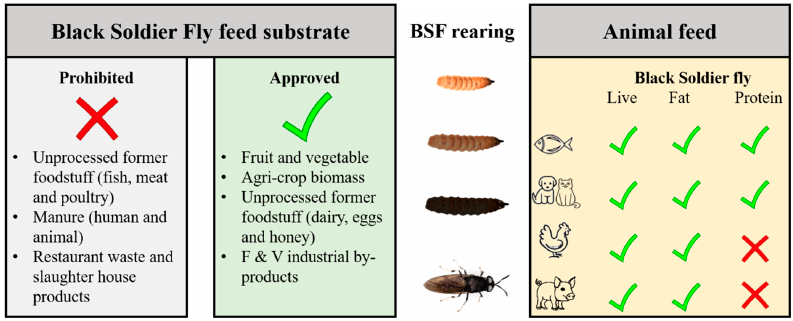
Figure 12. Substrates approved for BSF rearing (adapted from the International Platform of Insects for Food and Feed (IPIFF)).